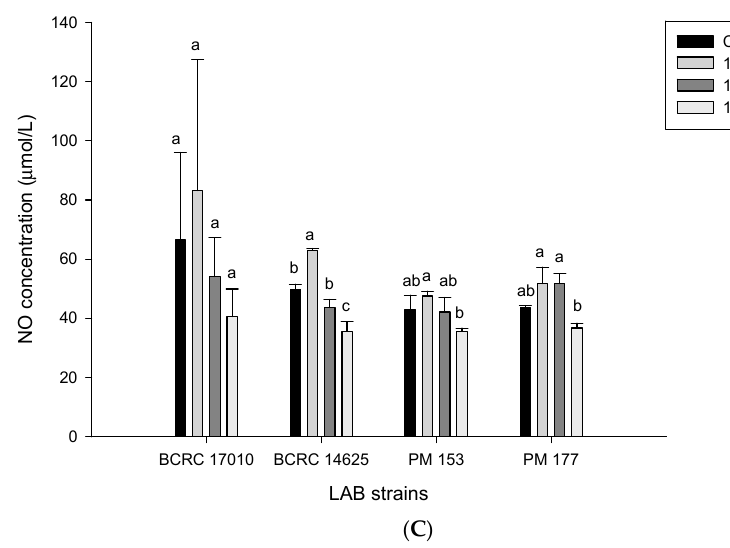
Figure 5. NO production was used by ( A ) lactic acid bacteria supernatant on HT-29 cell line after 24 h or four lactic acid bacteria strains on HT-29 cell line after ( B ) 4 h ( C ) 8 h incubation. The control means untreated cells. Data are expressed as means ± SD, a–e Values with different symbols are significantly different in the same LAB strain group at the level of p < 0.05 by One-way ANOVA.